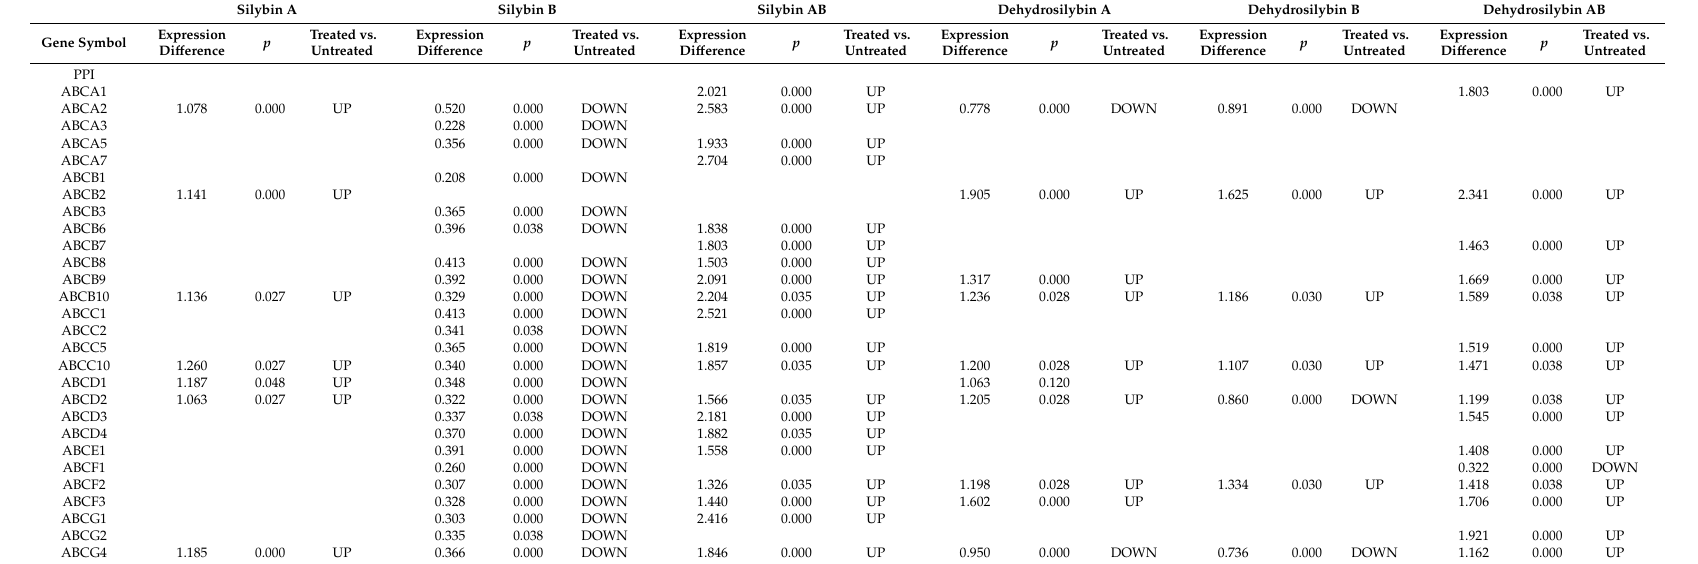
Table A1. E ff ect of silybin and dehydrosilybin isomers on expression of ABC (ATP-binding cassette) superfamily genes in doxorubicin-resistant ovarian carcinoma (A2780 /